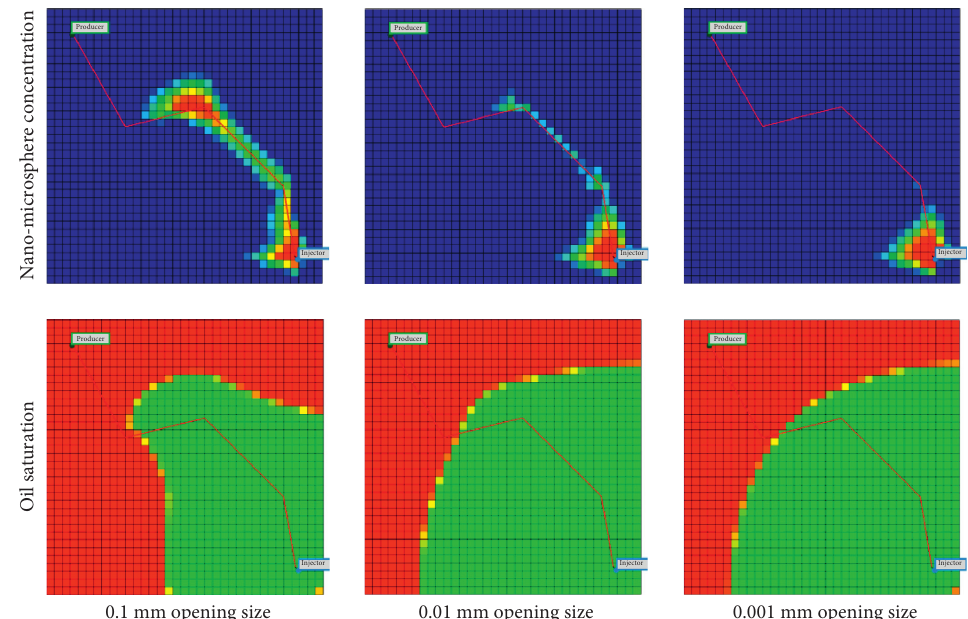
Figure 13: Chemical agent concentration and oil saturation distribution after control and flooding with nano-microspheres in fractured reservoirs with variable opening